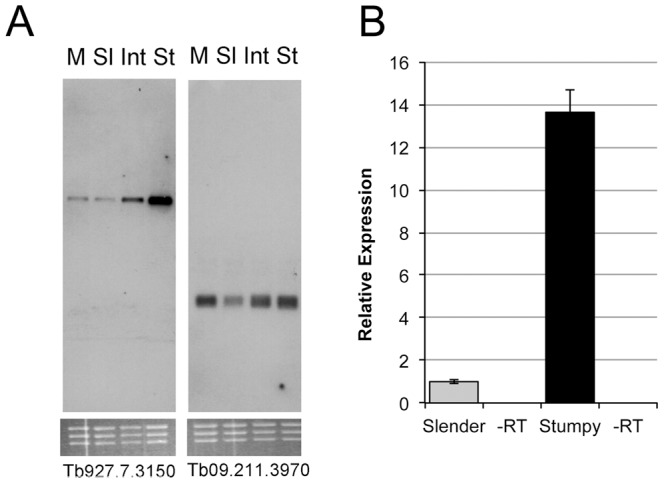
Expression profile of Tb927.7.3150.A. Northern blot validation of the developmental expression of transcript Tb927.7.3150. RNA from monomorphic slender (M) and pleomorphic slender (Sl), intermediate (Int) and stumpy (St) forms of T. brucei AnTat 1.1 was hybridized with riboprobes specific for either Tb927.7.3150 (left hand panel) or a control transcript Tb09.211.3970. The expression of Tb927.7.3150 progressively increases from slender to intermediate, being highest in stumpy forms. B. Realtime qRTPCR of the relative expression of Tb927.7.3150 in slender and stumpy forms of T. brucei AnTat 1.1. Transcript Tb927.10.13860 (GPI8) provided the normalisation control.